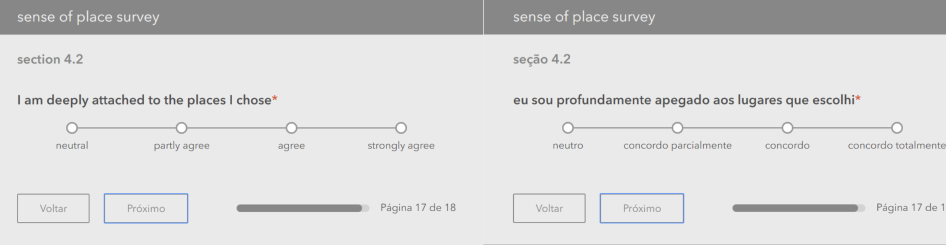
Figure 19: Likert question for place